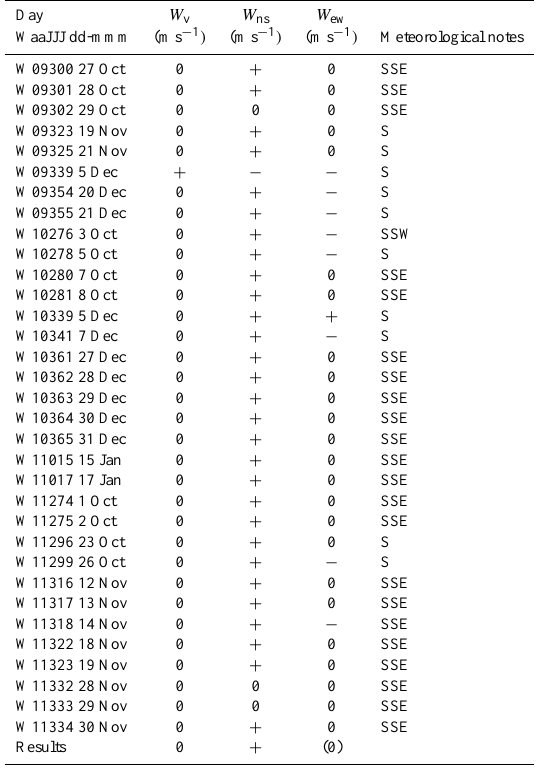
Fig. 13. Stratiform precipitation pattern: meteorological observations plot from the automatic weather station (AWS) on 31 January 2010, including air temperature, humidity, precipitation, pressure, mean wind direction, and wind velocity.